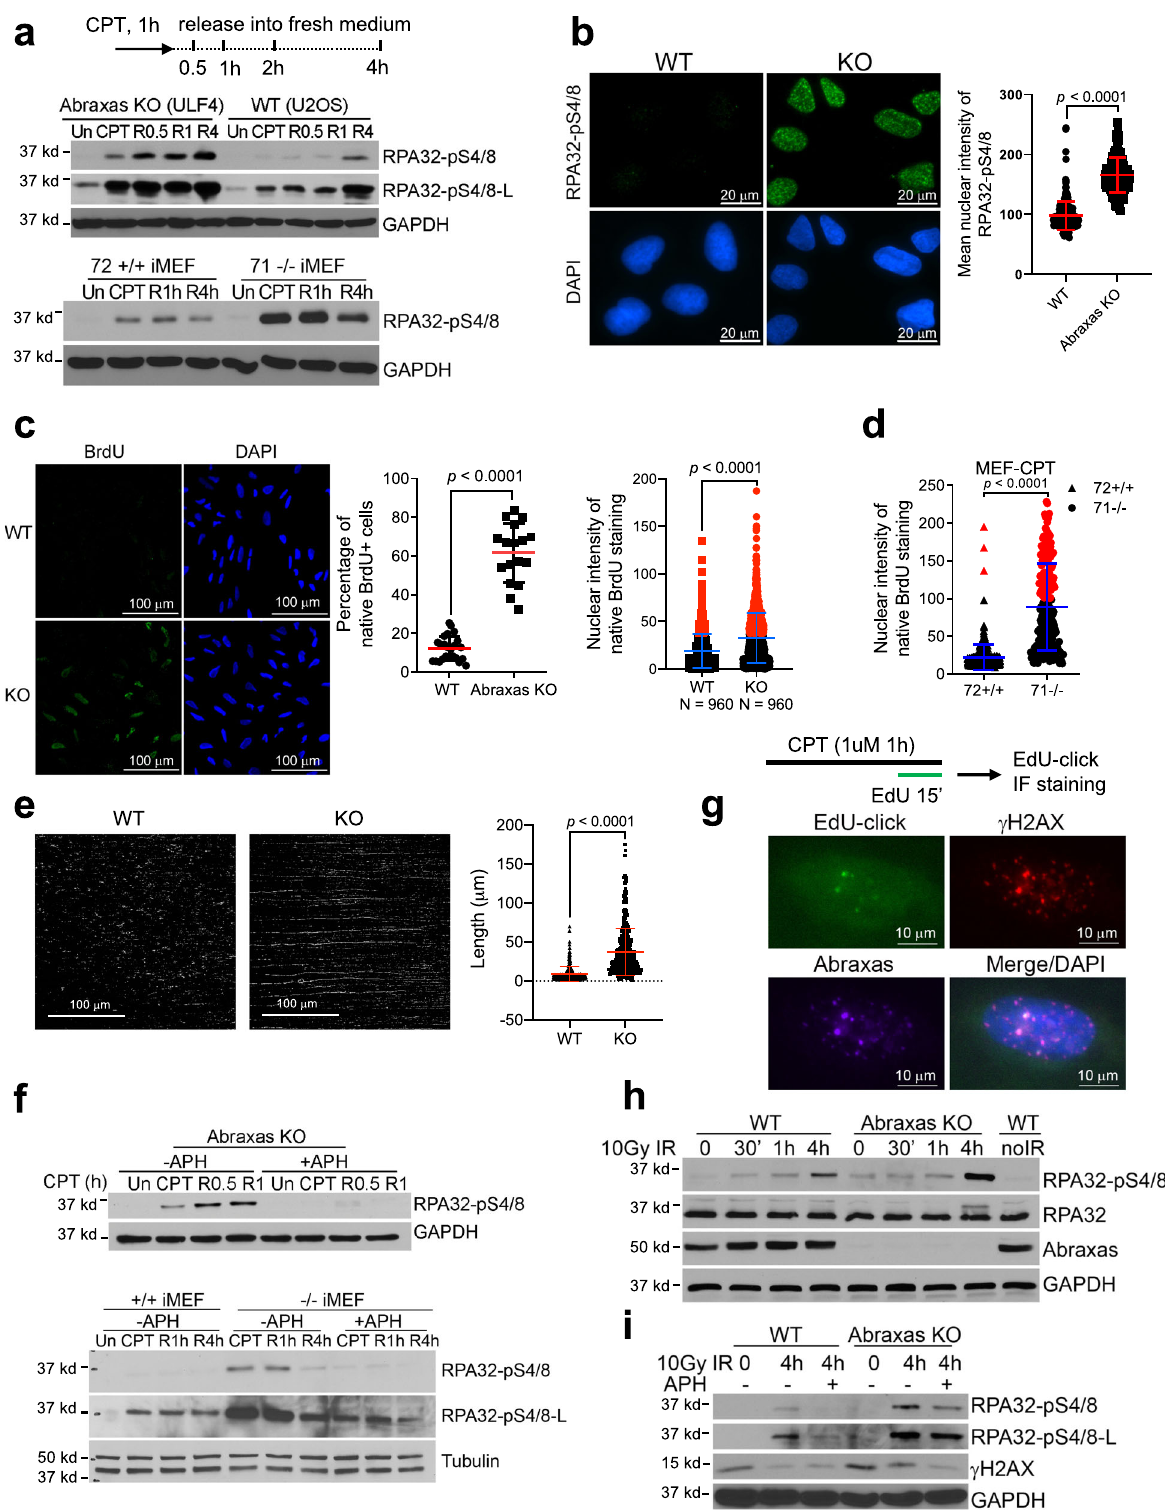
previous fi ndings that Abraxas does not play a role in responding to replication stress induced by HU at stalled replication forks for fork protection or restart of stalled replication forks 30 . Treatment with Mitomycin C (MMC) or poly (ADP-ribose) polymerase inhibitor, which forms DNA crosslink or protein – DNA crosslink that impedes DNA replication, however, led to elevated pRPA levels in Abraxas KO cells when compared to the control